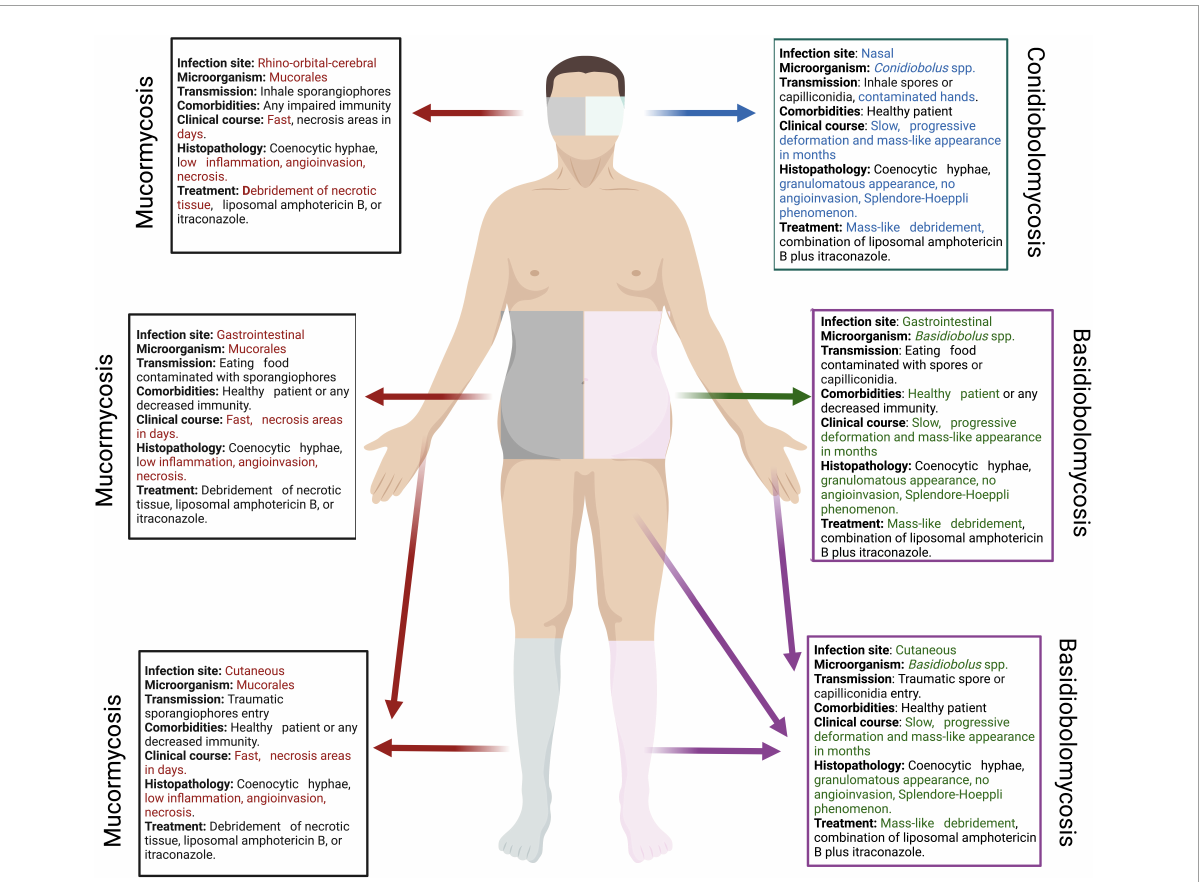
FIGURE1 Main differences between basidiobolomycosis, conidiobolomycosis and mucormycosis. On the left, the main differences of the main forms of mucormycosis (red), conidiobolomycosis (blue) and basidiobolomycosis (green) are explained. This image was created with Biorender.com.